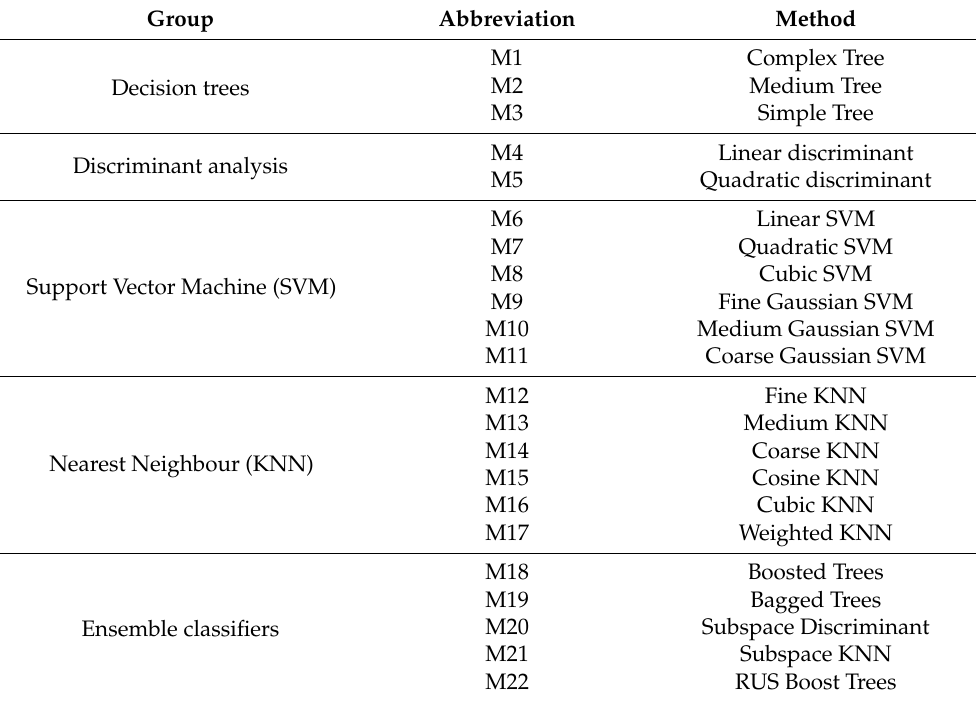
Table 3. Evaluated